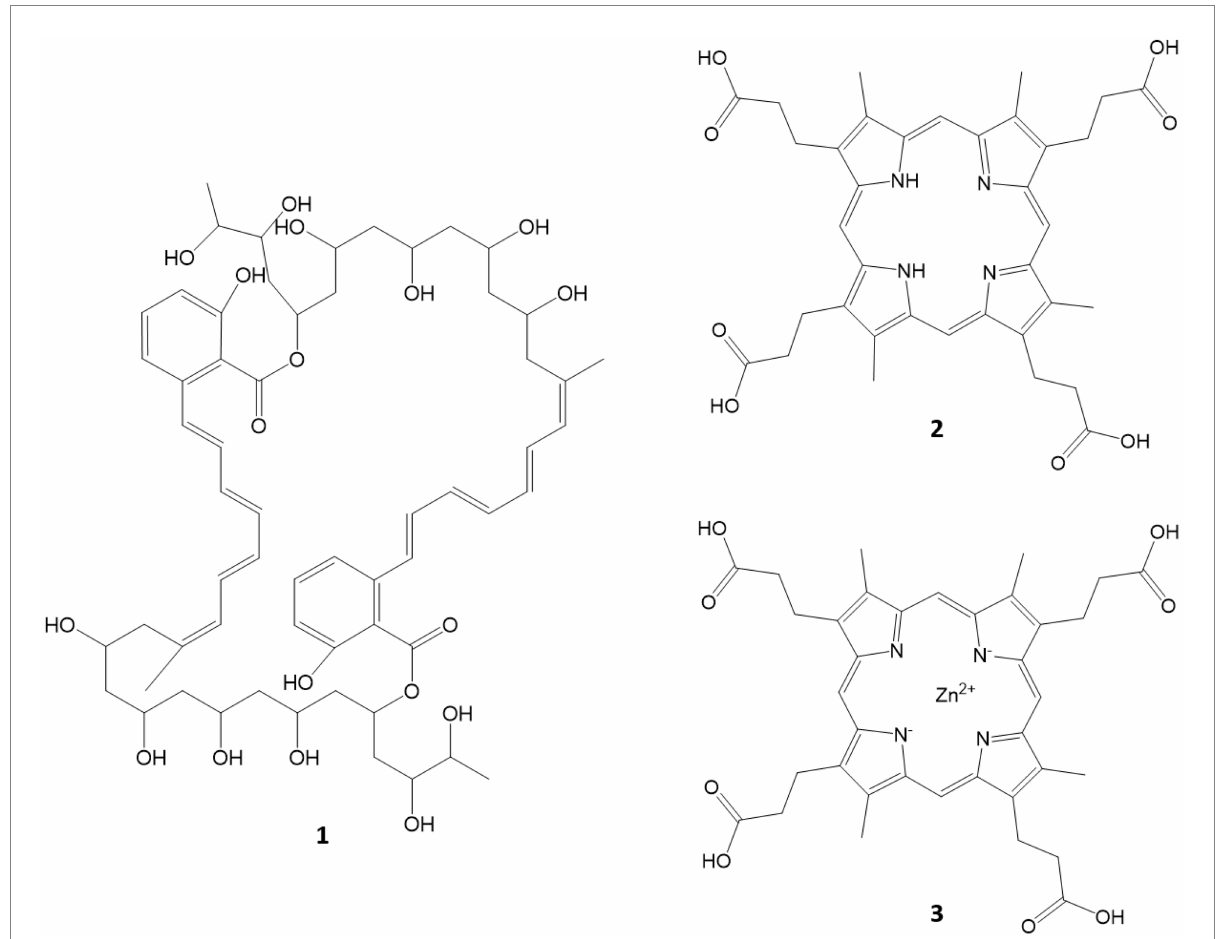
FIGURE 8 Compounds tentatively identified via MS/MS and UV/Vis spectra. SIA7248 (1), coproporphyrin III (2) and Zn coproporphyrin III